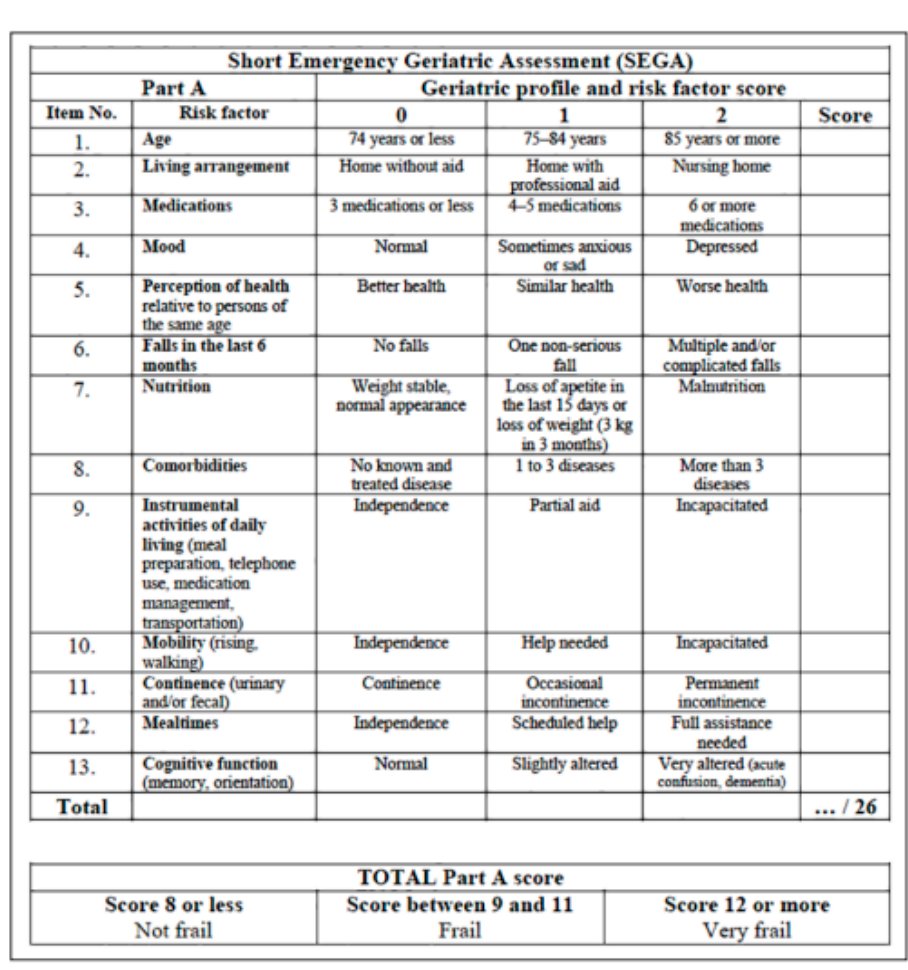
Figure 1. Modified SEGA scale part A.